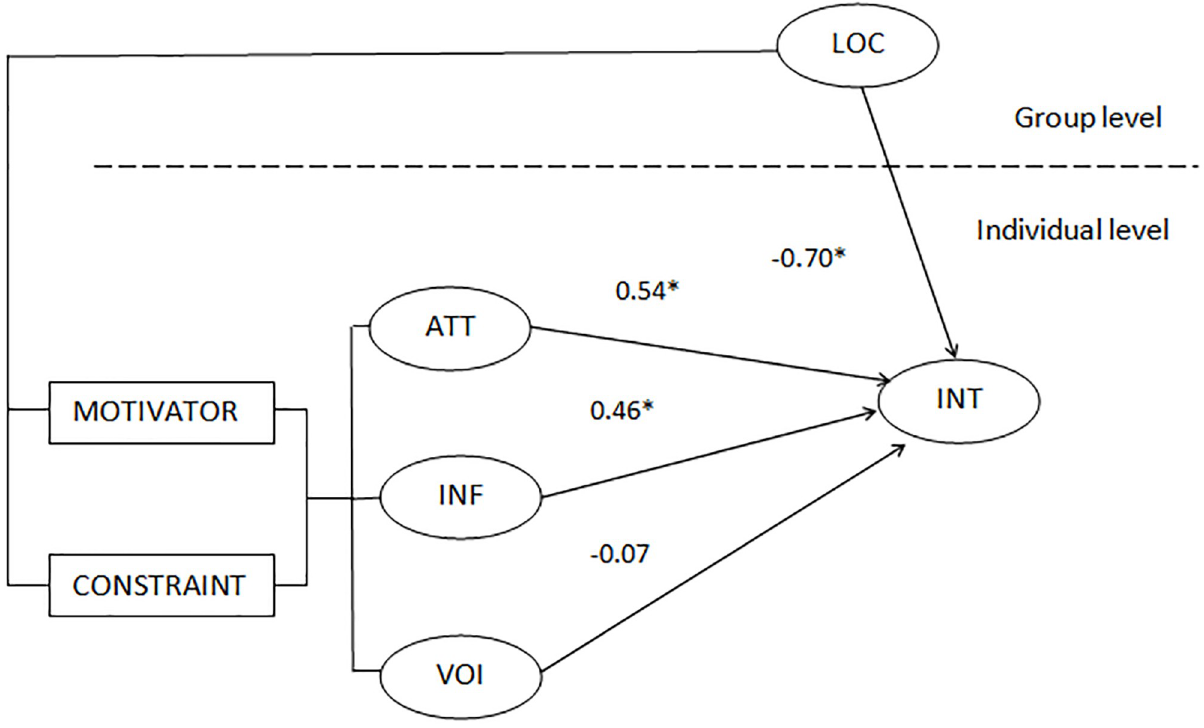
Fig 2. The estimated multilevel